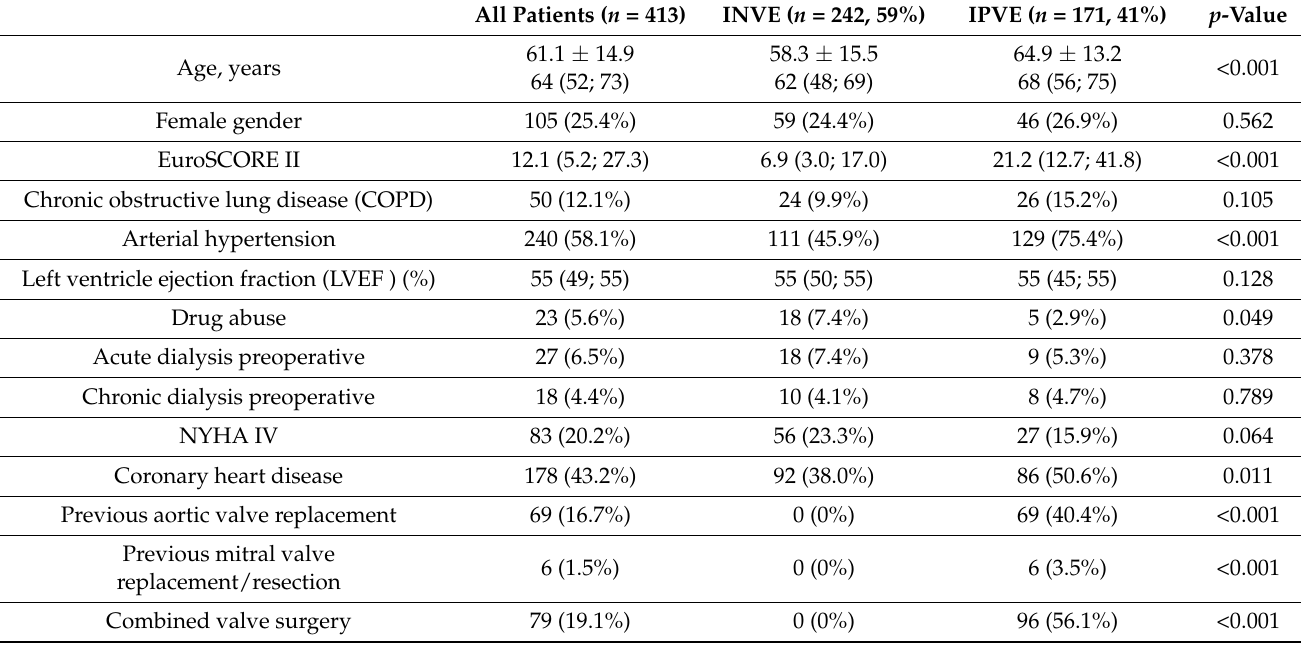
Table 1. Demographic and clinical characteristics of the study